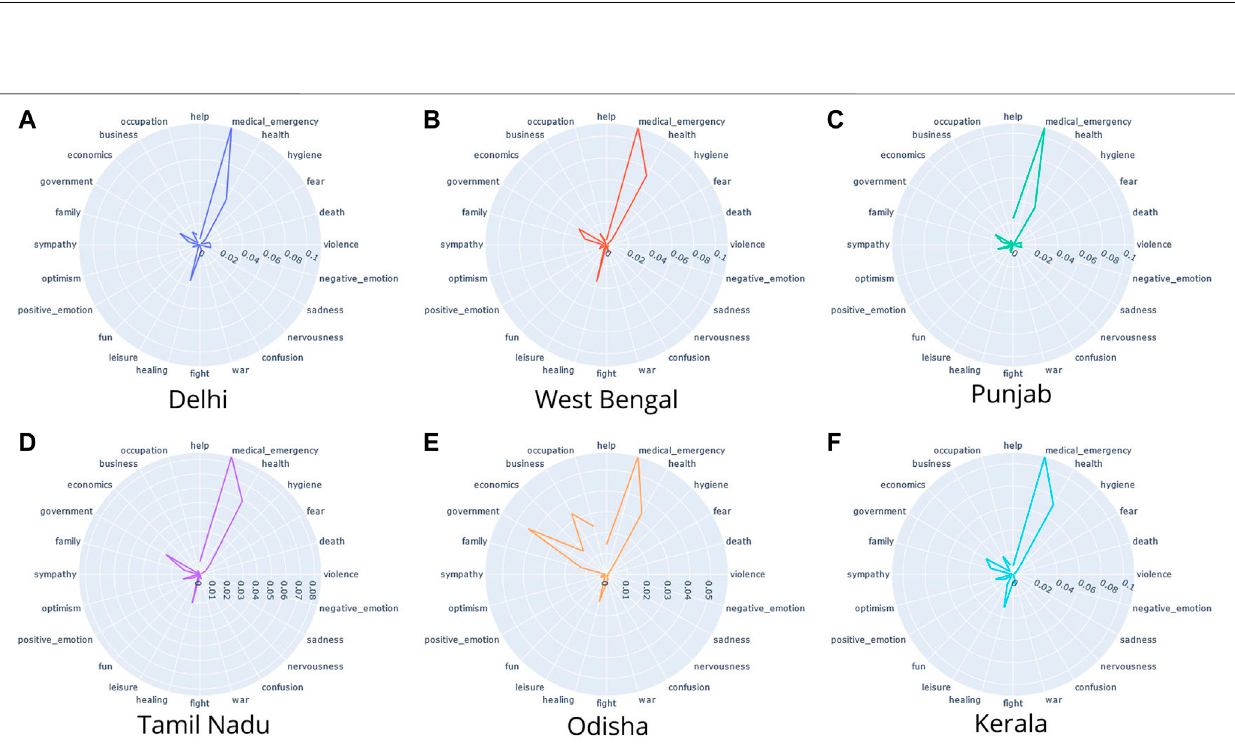
Frontiers in Communication |